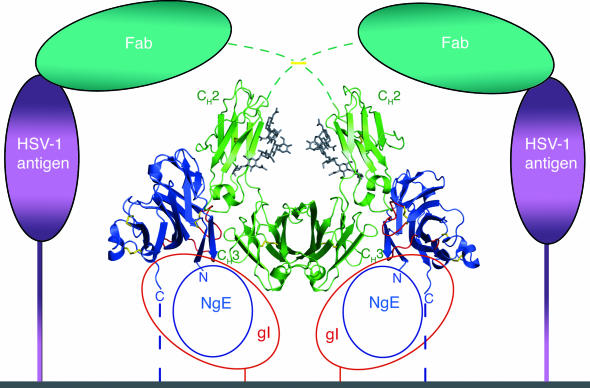
The three-dimensional structure of a gE-gI/Fc complex suggests that an anti-HSV IgG bound by gE-gI is in an upright orientation, positioning it to also bind its antigen on the surface of the same cell.